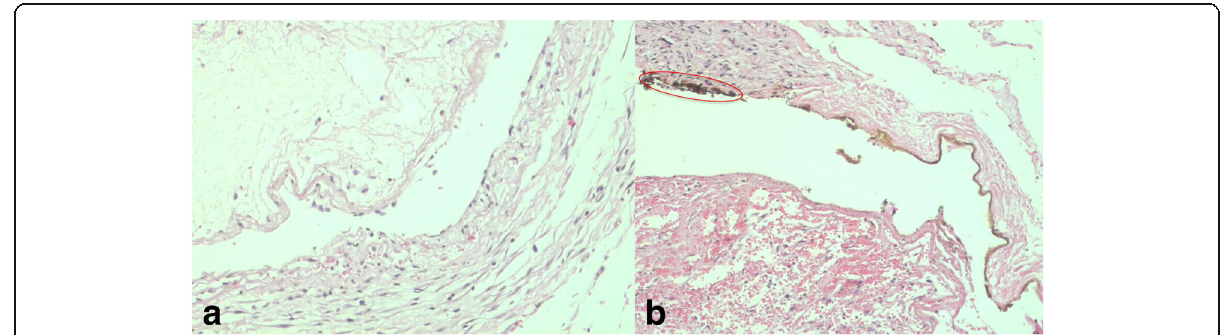
Fig. 3 a The sample of the control group at day 7. b The sample of the study group at day 7, brown-black granules ( encircled ) (H&E; a , b